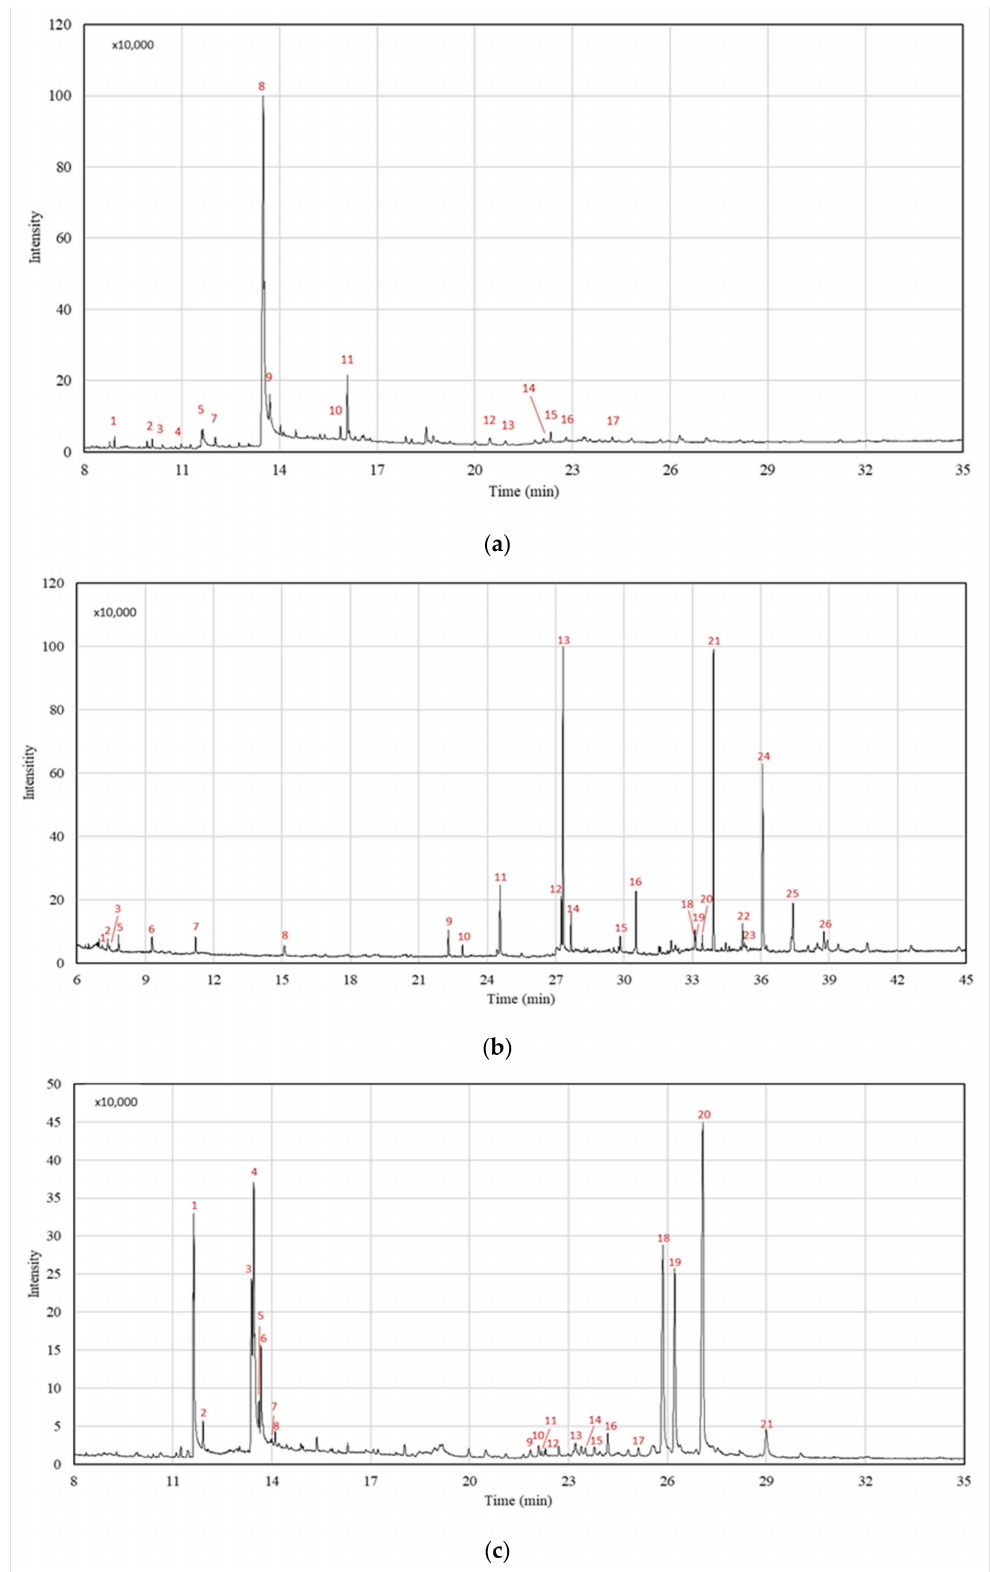
Figure 2. Examples of chromatograms SFE-CO 2 extracts obtained from Mo ( a ) seeds, ( b ) leaves, and ( c ) roots at 273 bar and 55 ◦ C, analysed by GC-MS. The numbers correspond to the molecules identified in Tables 3–5,